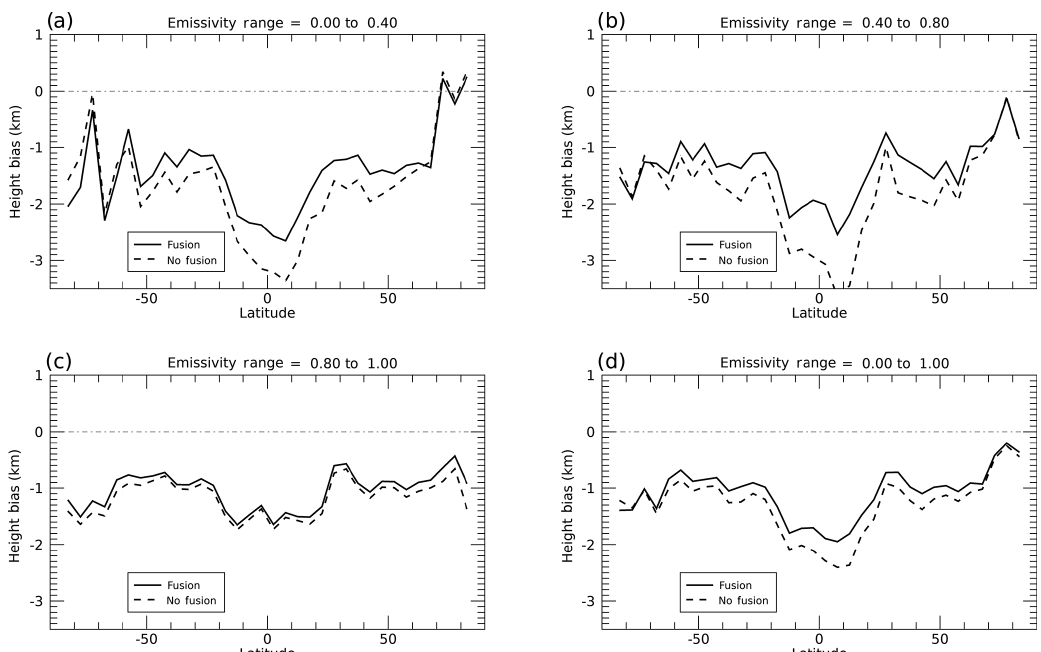
Figure 5. Zonal distribution of cloud height biases between S-NPP VIIRS and CALIPSO/CALIOP for emissivity ranges of (a) 0 to 0.4; (b) 0.4 to 0.8; (c) 0.8 to 1.0; and (d) 0 to 1.0. Solid and dashed lines indicate data with and without fusion